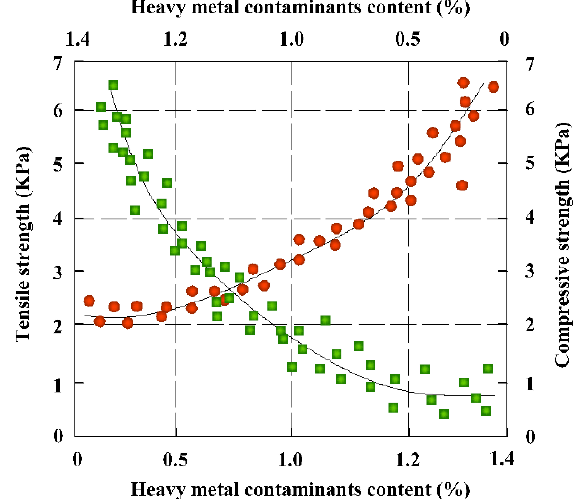
Fig. 4. The relationship between tensile and compressive strength and heavy metal